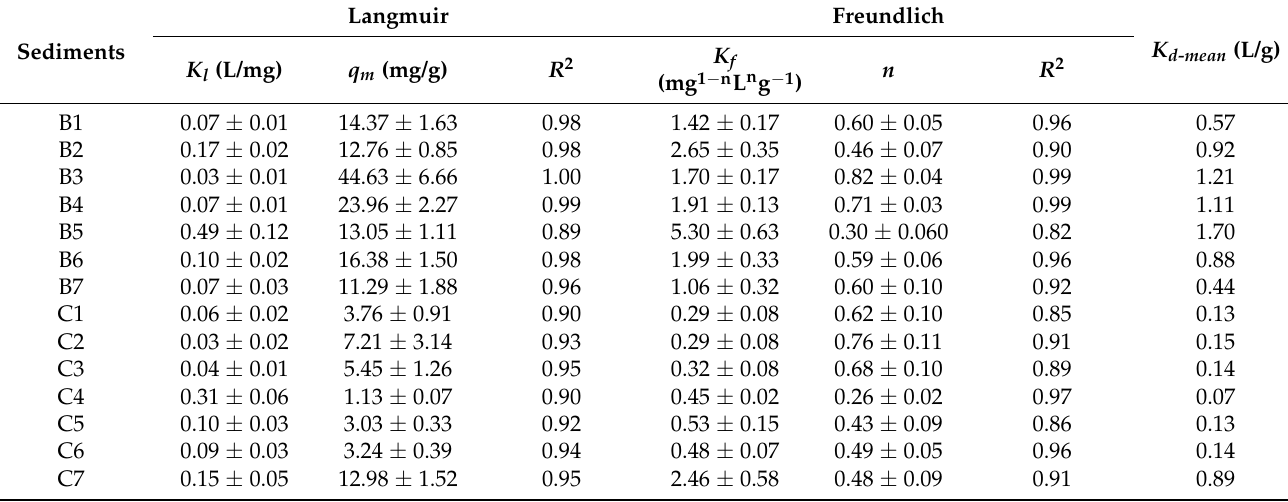
Table 2. Values of Langmuir and Freundlich parameters obtained in the present